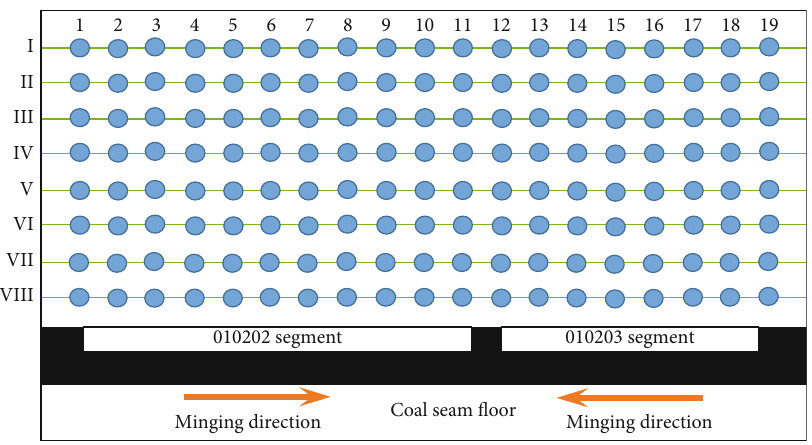
Figure 6: Schematic layout of monitoring points for similar test